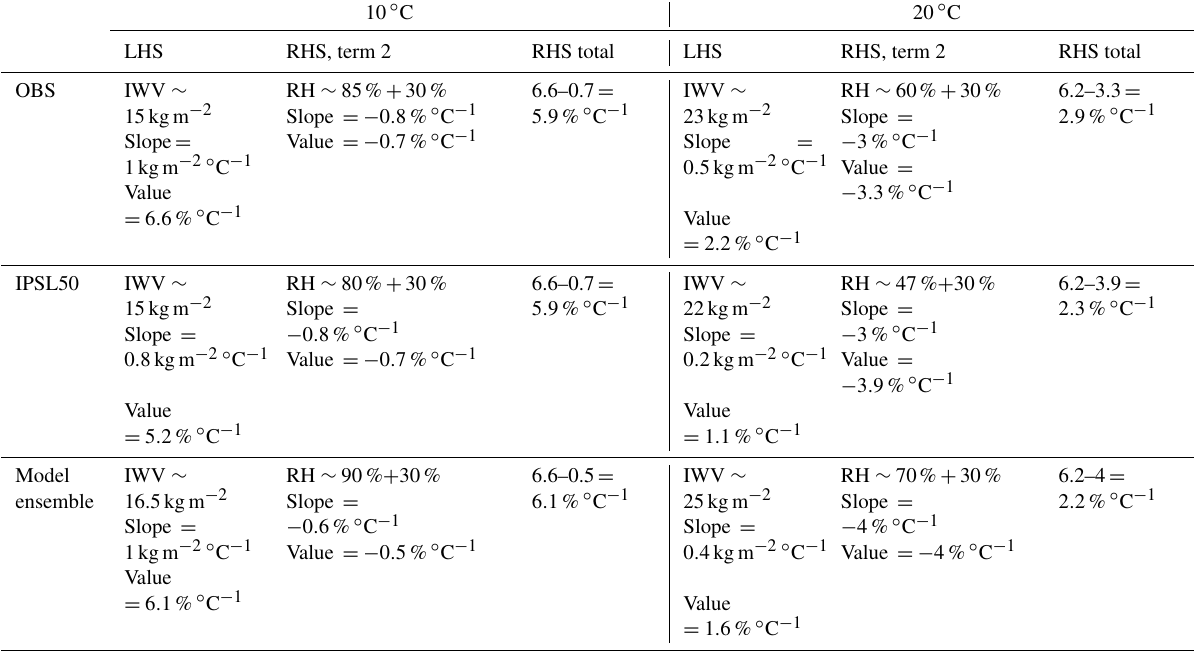
Table 6. Values of the left-hand side (LHS), second term of the right-hand side (RHS) and total RHS of Eq. (2) computed for the SIRTA site for two different temperatures (10 and 20 ◦ C), according to Fig. 5d for observations and Fig. 6a for